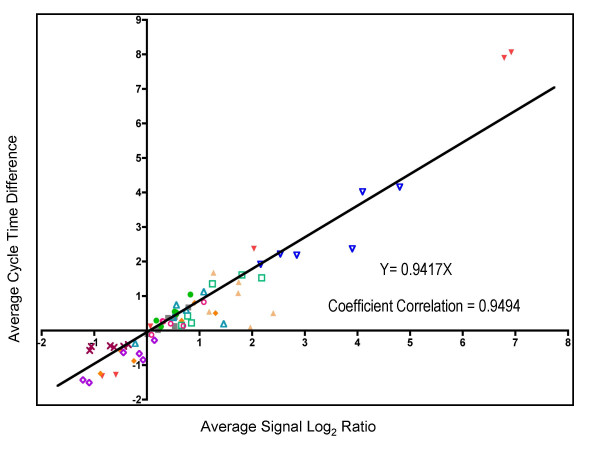
Quantitative real-time RT-PCR of eleven transcripts. Comparison between the gene expression ratios reported by the Affymetrix GeneChip® genome array and by real-time RT-PCR. Data were from 11 probe sets across seven developmental stages. The difference in the number of PCR cycles required to produce the same amount of product is plotted against the log2 expression ratio averaged over the first time point. The linear regression line was constrained to pass through the origin. Grey solid square (1615402_at, TC56083)-ferulate-5-hydroxylase, Apricot solid triangle (1606794_at, TC63891)-osmotin precursor, red solid triangle (1616700_at, TC53526)-sucrose synthase, orange solid diamond (1607760_at, TC51695) flavonoid-3'5'-hydroxylase, light green solid round (1611650_at, TC57228)-WRKY7, dark green open square (1616880_at, TC54034)-cinnamoyl alcohol dehydrogenase, dark blue open triangle (1613896_at, TC62182)-nitrate/chloride transporter), blue open triangle (1615722_s_at, TC51776)-aquaporin PIP1.1, lavender open diamond (1611342_at, TC55943)-serine/threonine kinase, pink open circle (1612132_s_at, TC68311)-protein phosphatase 2C, brown cross (1614931_at, TC61058)-MYB transcription factor.